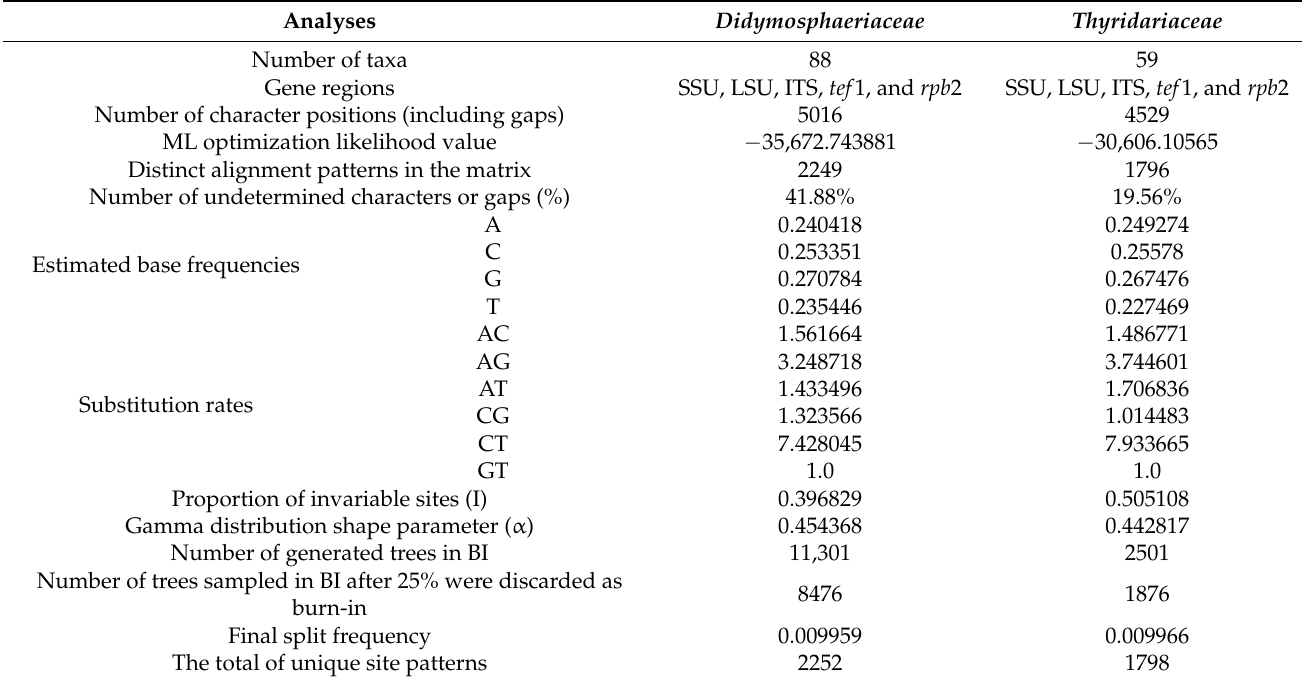
Table 3. Maximum-likelihood (ML) and Bayesian (BI) analyses results for each sequenced